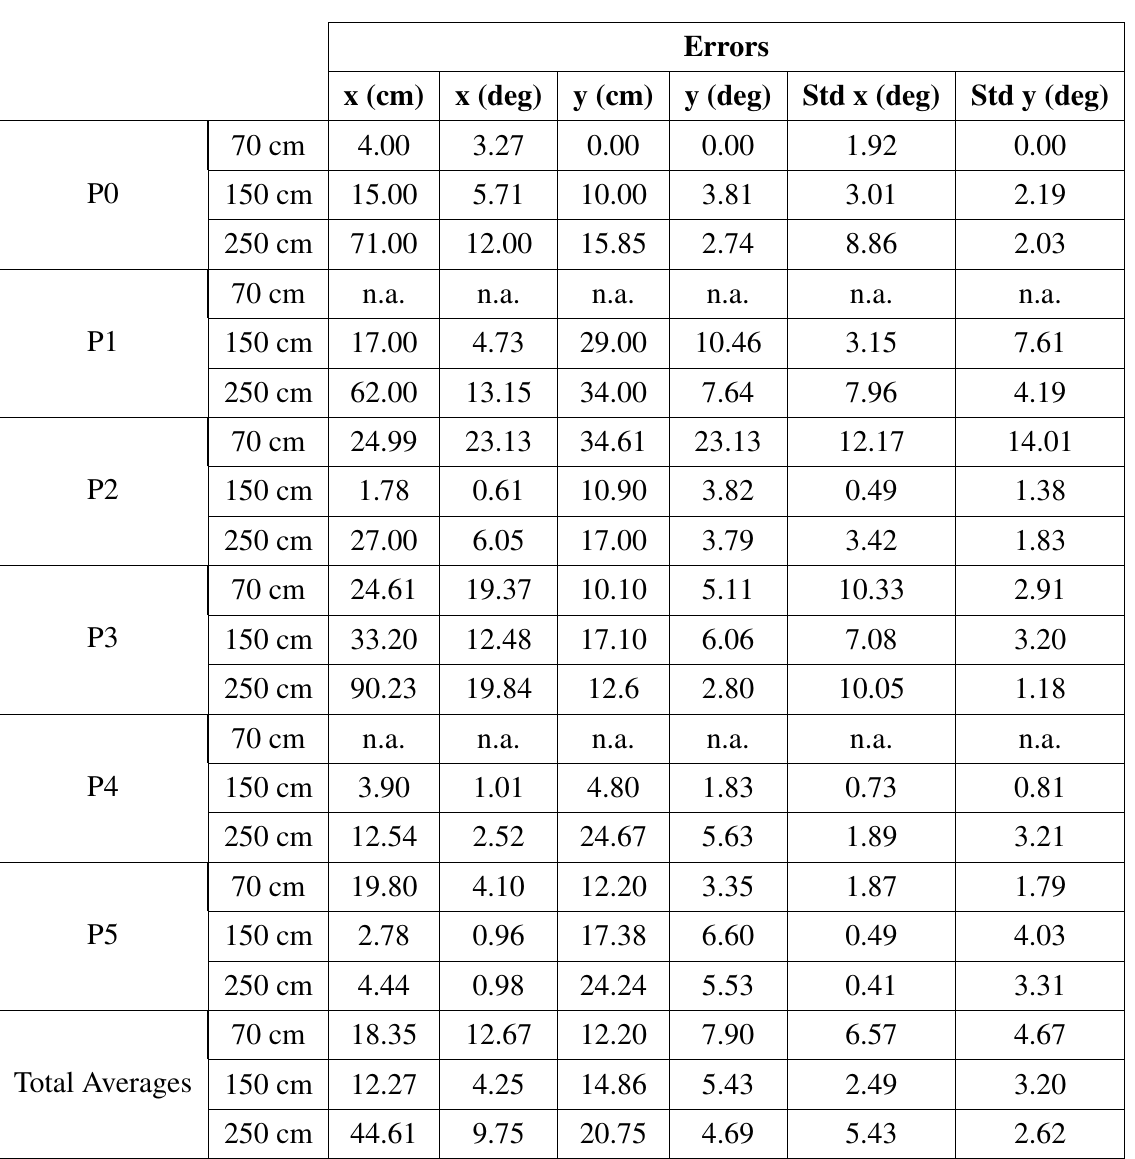
Table 3. Experiments with the third group of persons that were totally unaware of how the system